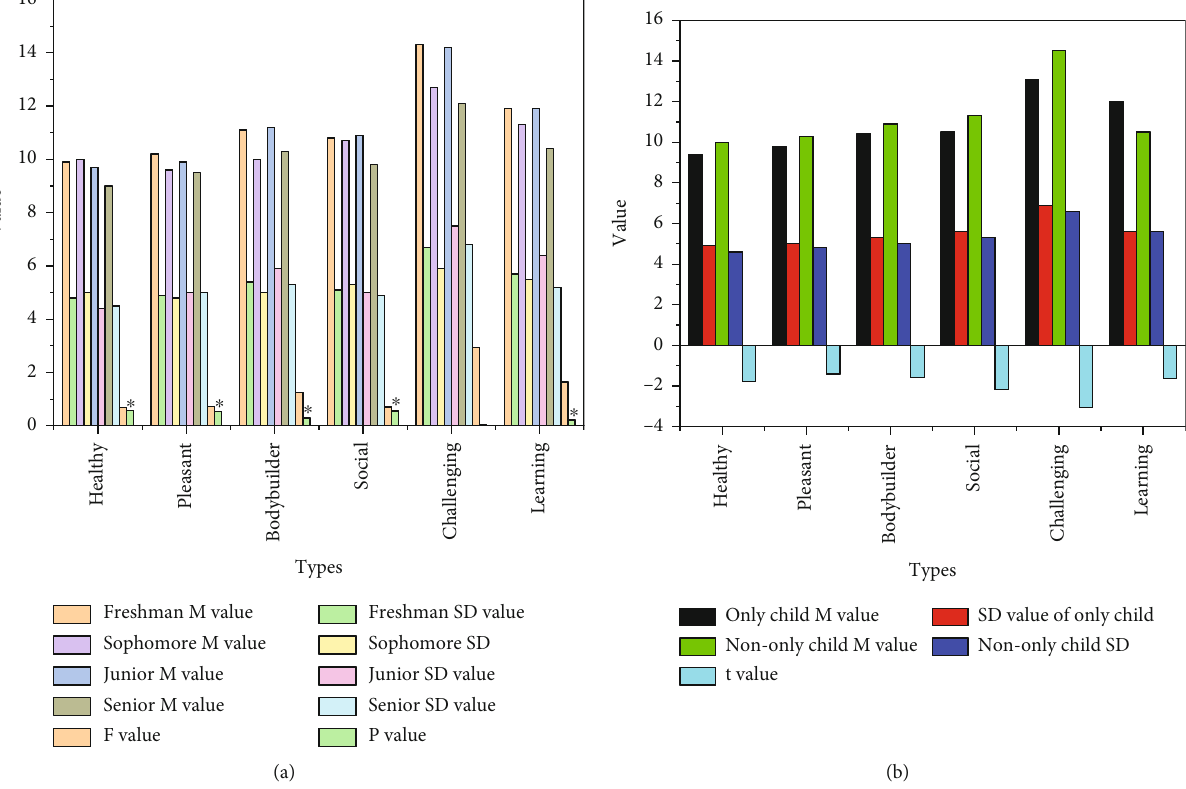
Figure 2: The result chart of the di ff erence of motivation of physical exercise among di ff erent grades and students who are only child or not ((a) di ff erences among students from di ff erent grades; (b) di ff erences among students who are only child or